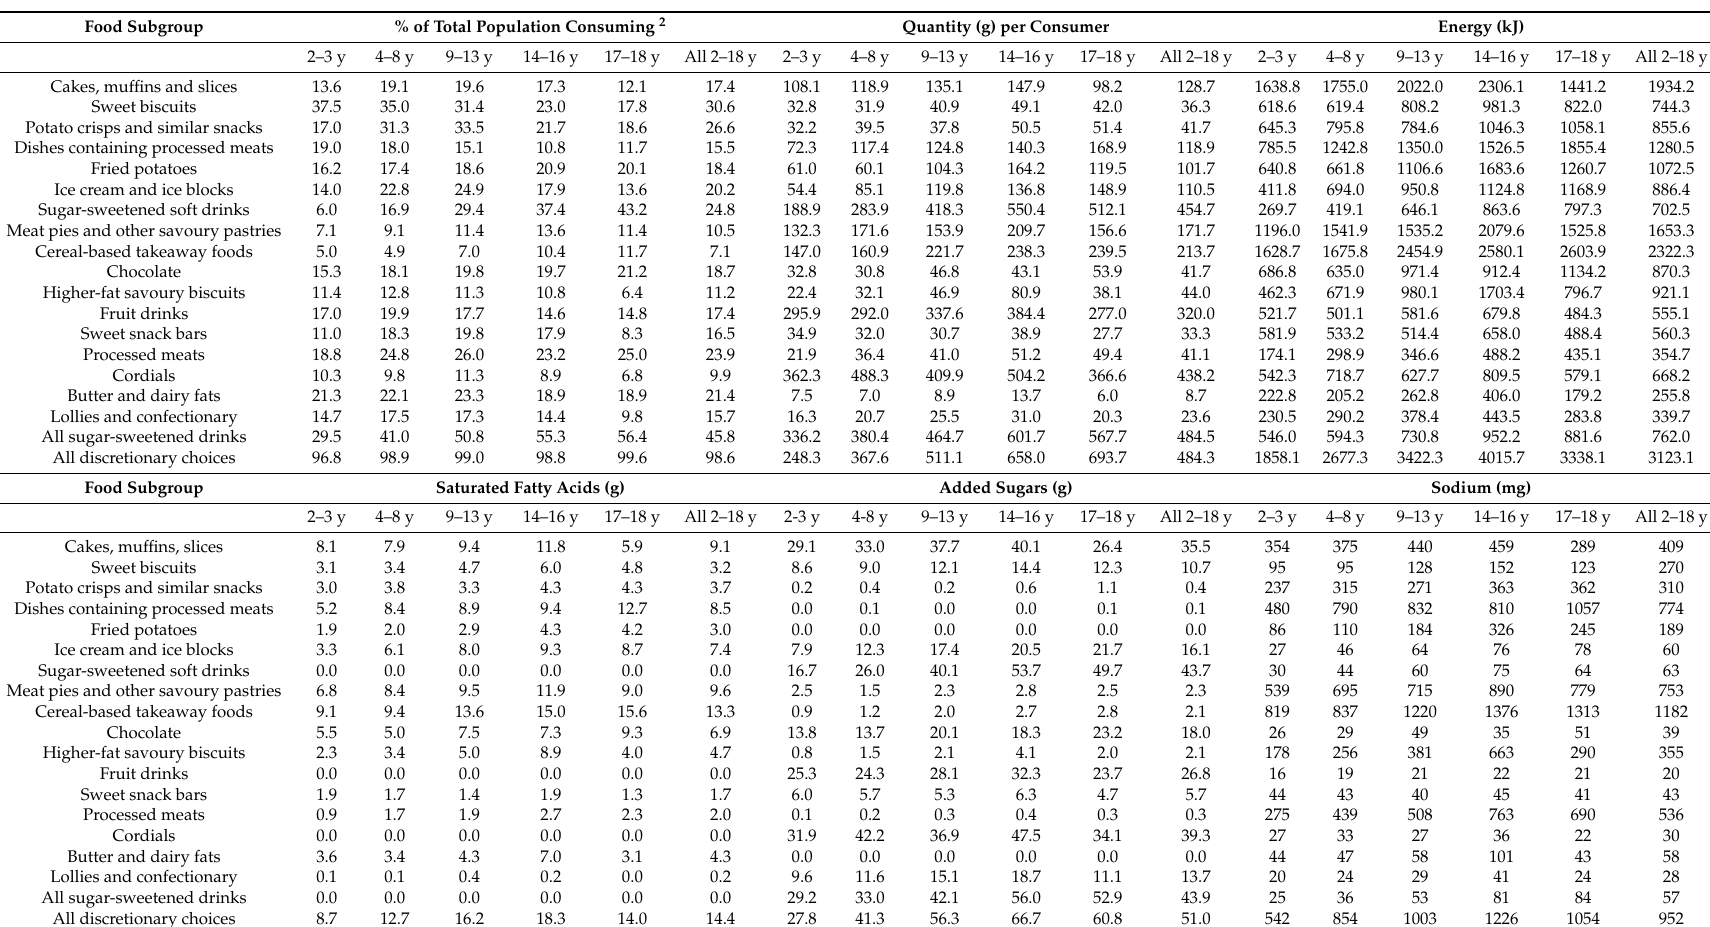
Table 2. Mean quantities consumed per consumers of discretionary choice subgroups by age group in the NNPAS 2011–2012 survey 1